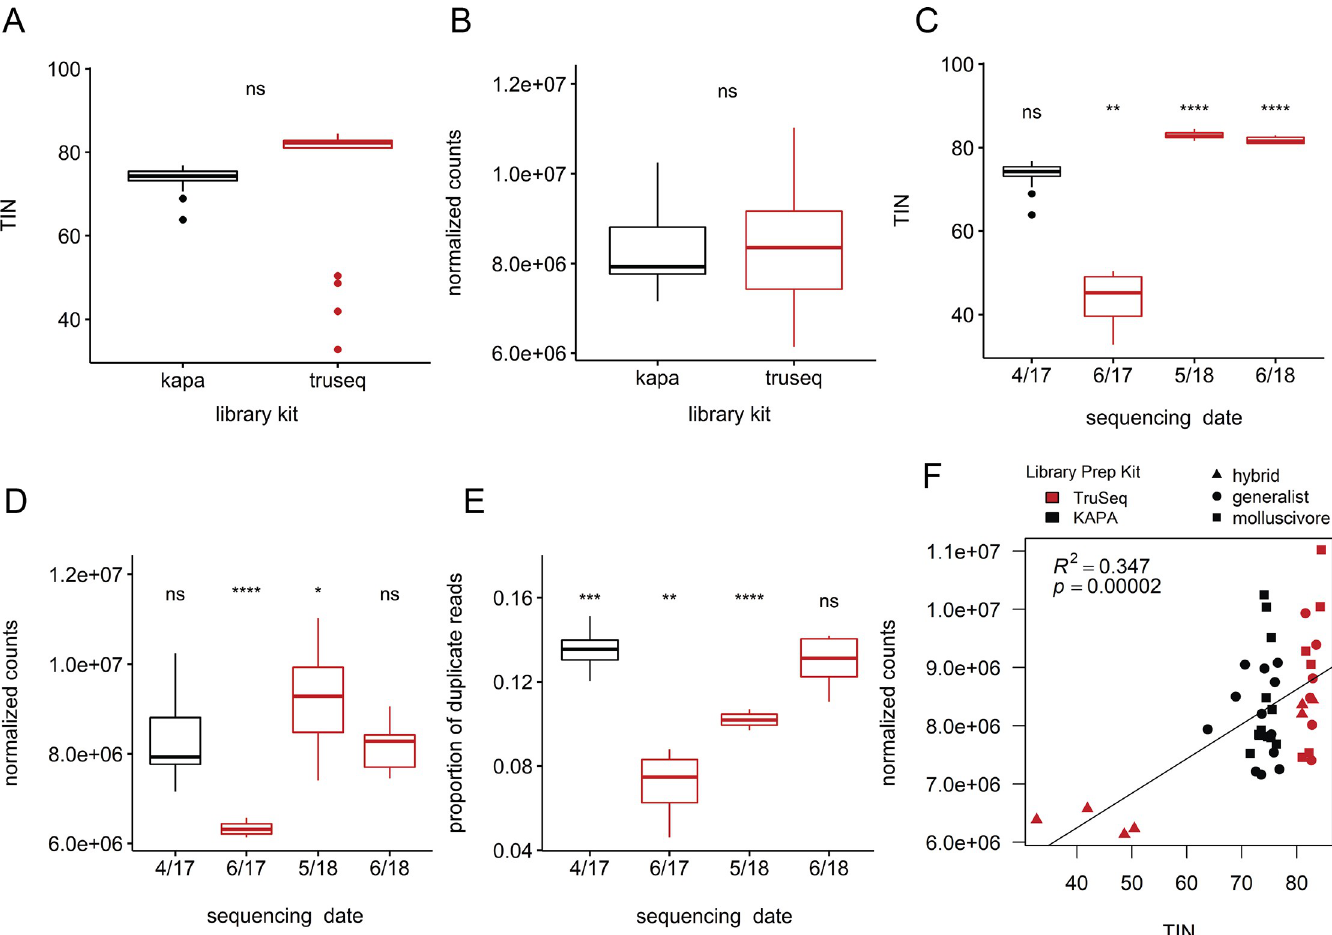
Fig 4. Effects of sequencing facility and library preparation kit. Boxplots show samples grouped by library preparation method (A and B) or by the date they were sequenced (C-E) and whether samples were prepared using Truseq stranded mRNA library kits (red) or KAPA stranded mRNA library kits (black). There was no difference in (A) median transcript integrity numbers (TIN) or (B) number of normalized counts between groups prepared with different library kits (Welch two sample t-test, P > 0.05). Hybrid craniofacial sampled 17–20 days post fertilization (sequenced 6/17) showed significantly lower (C) TIN, (D) normalized read counts, and (D) proportion of duplicate reads compared to samples sequenced on other dates (Pairwise Welch two sample t-test; P < 0.0001 = ���� , ��� = 0.001, �� = 0.01, � = 0.05). F) Lower TIN was correlated with lower normalized read count.